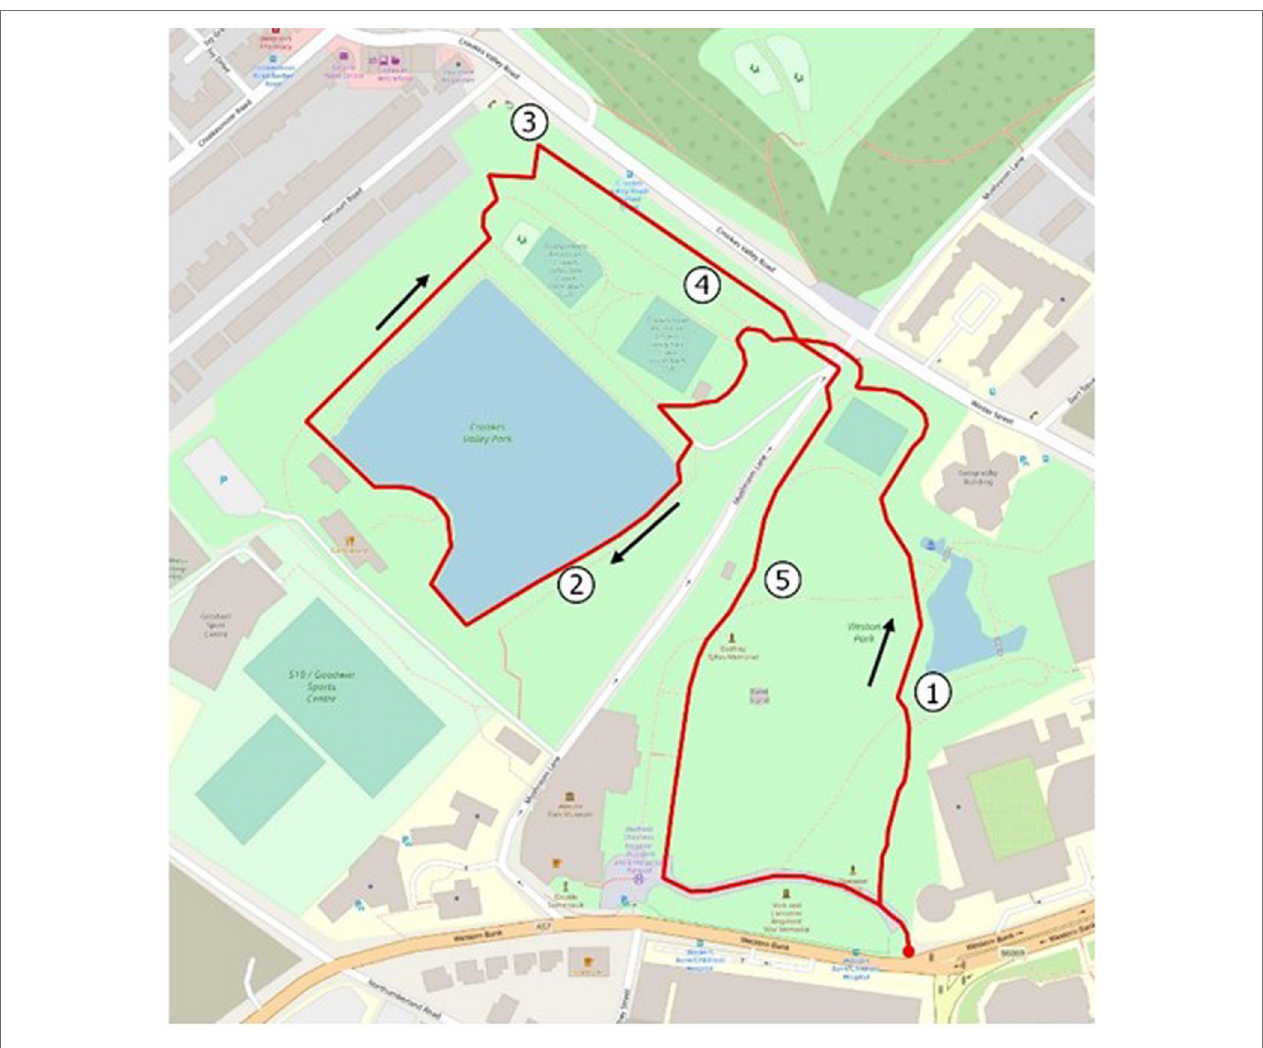
FIGURE 3 | Map of walk route in Sheffield, United